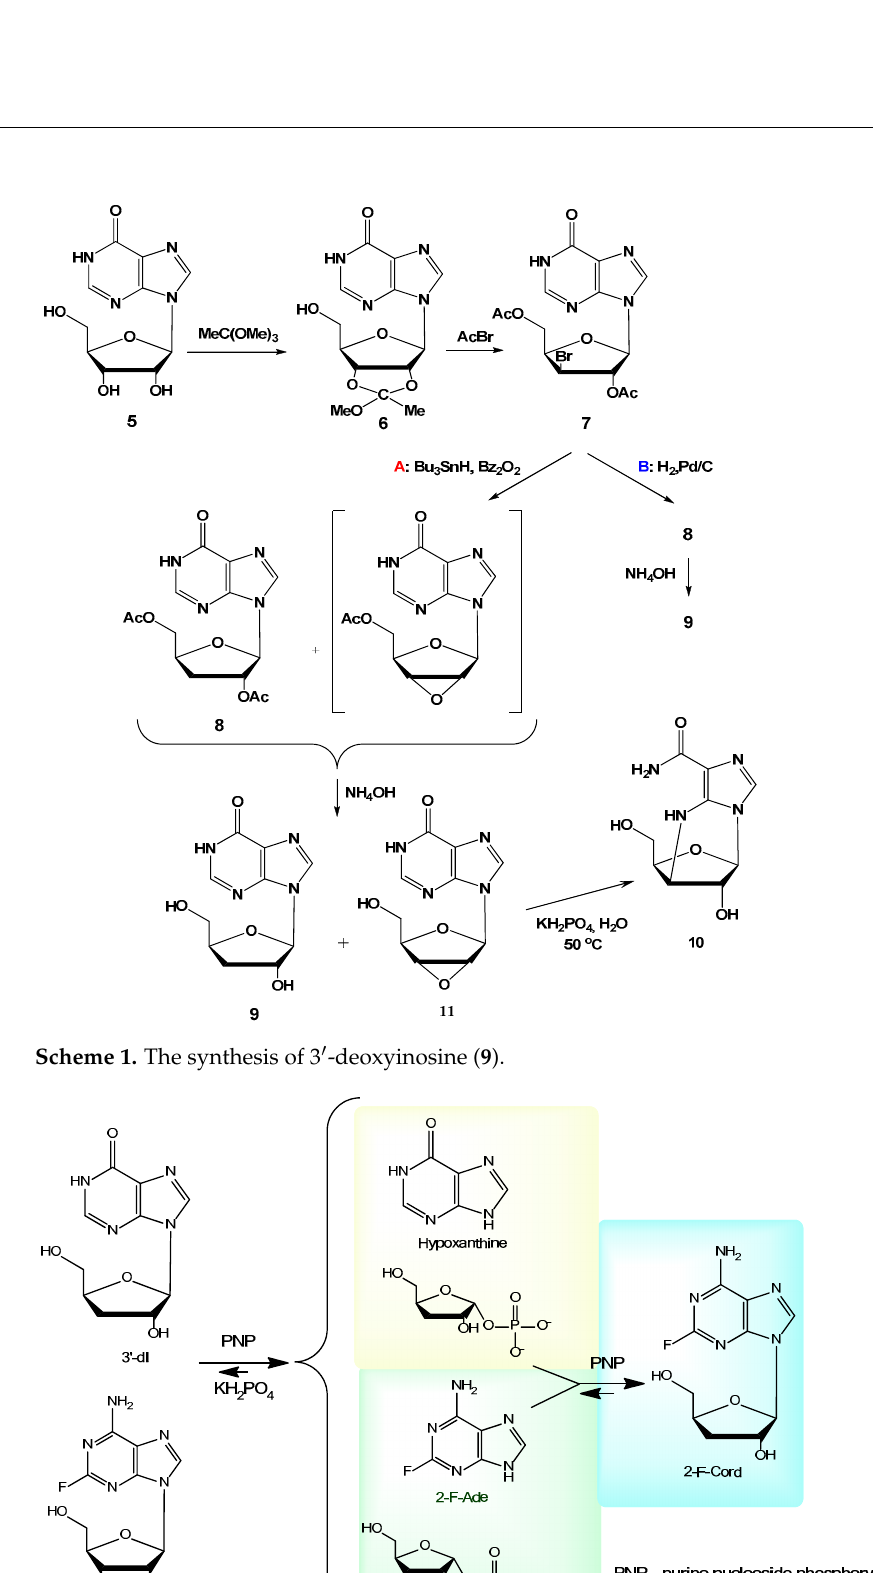
Scheme 2. The synthesis of 2-fluorocordycepin ( 3 ).